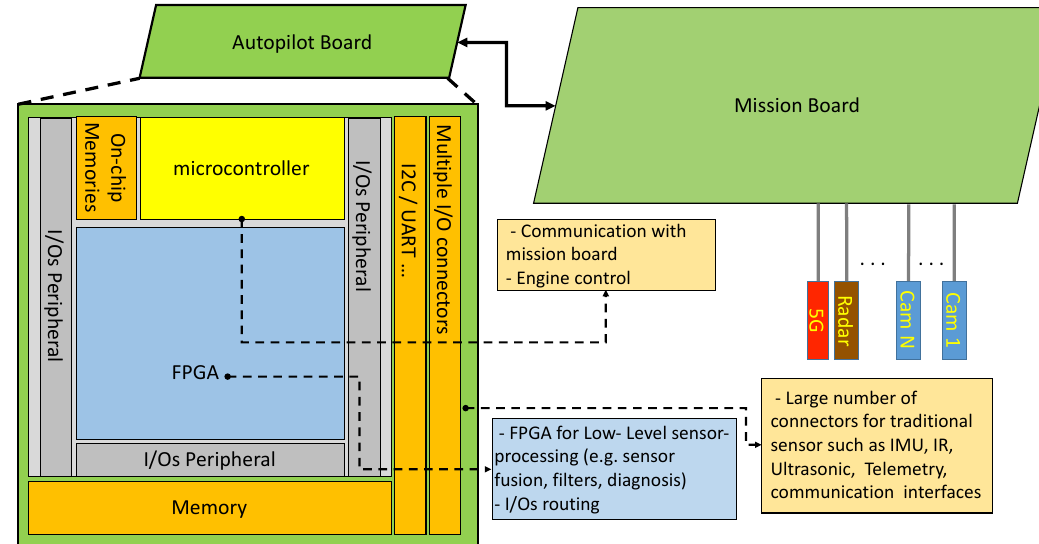
Figure 6. Architecture model for a reconfigurable autopilot board. Interaction and overview of the mission board is detailed in Figure